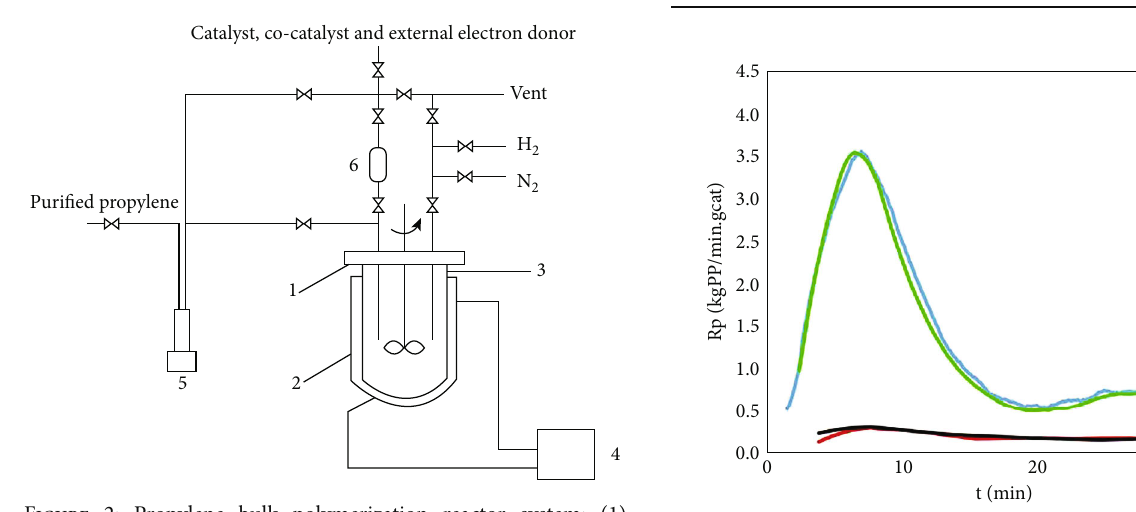
Figure 2: Propylene bulk polymerization reactor system: (1) reactor lid, (2) reactor jacket, (3) stainless steel reactor, (4) temperature control system, (5) syringe pump, and (6) catalyst feeding pot.